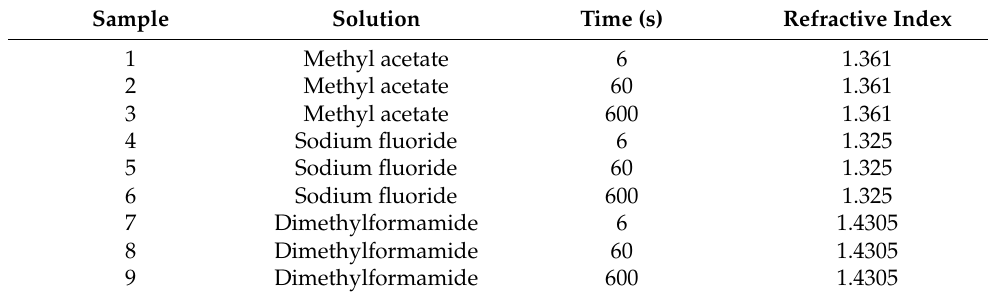
Table 1. Time of immersion of all